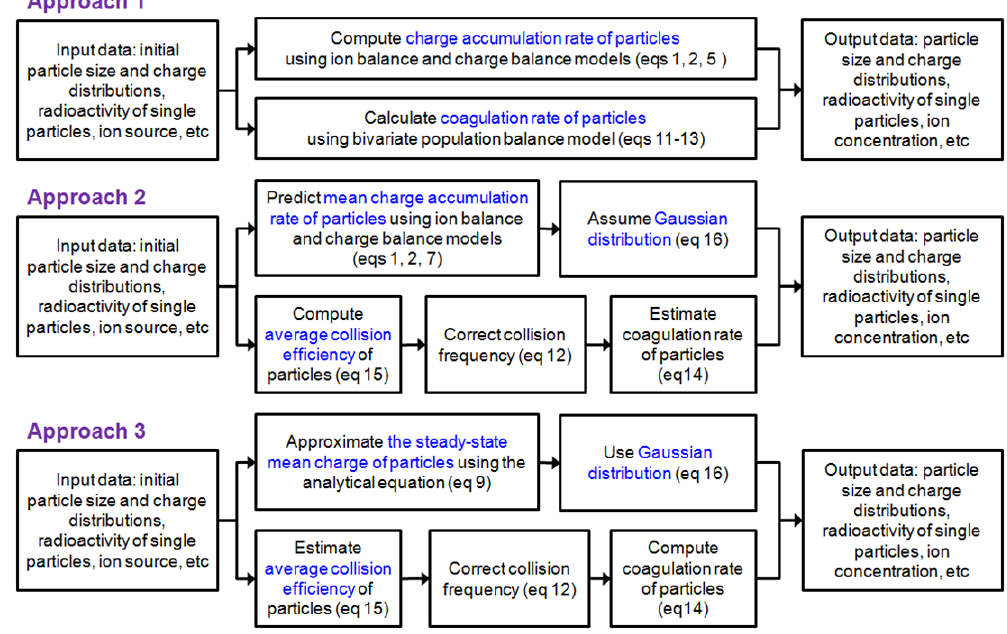
Figure 1. Three approaches to predict time-dependent changes in the particle size and charge distributions in the